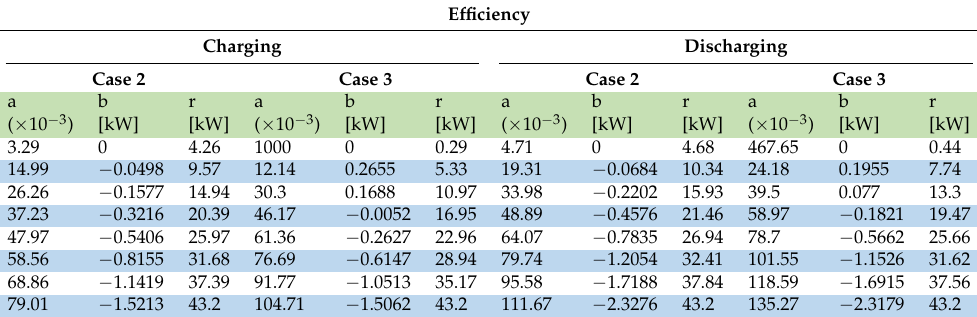
Table A4. PWA approximation parameters for power loss ( r 0 = 0 is omitted).